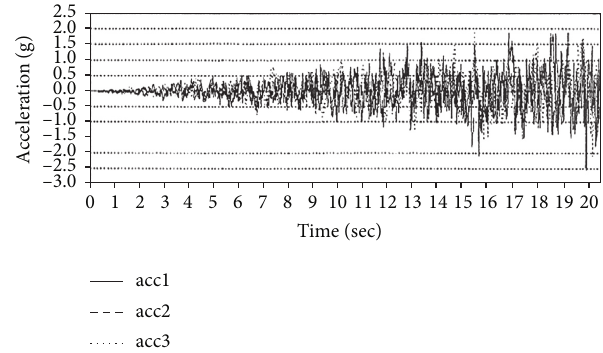
Figure 7: First series acceleration functions.